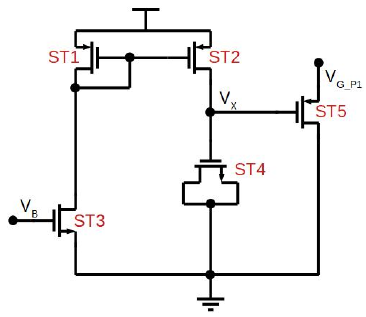
Figure 14. The start-up circuit. Table 6. Transistors dimensions of the start-up circuit.